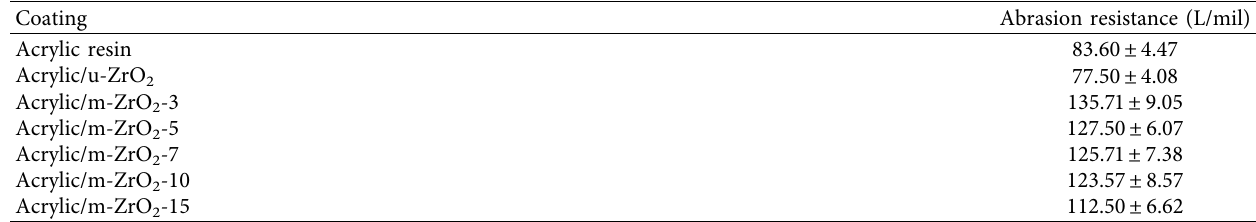
Figure 7: Zeta potential of u-ZrO 2 (a) and m-ZrO 2 -3 (b) nanoparticles. Table 3: Abrasion resistance of coating based on acrylic resin and 2 wt.% ZrO 2 nanoparticles.